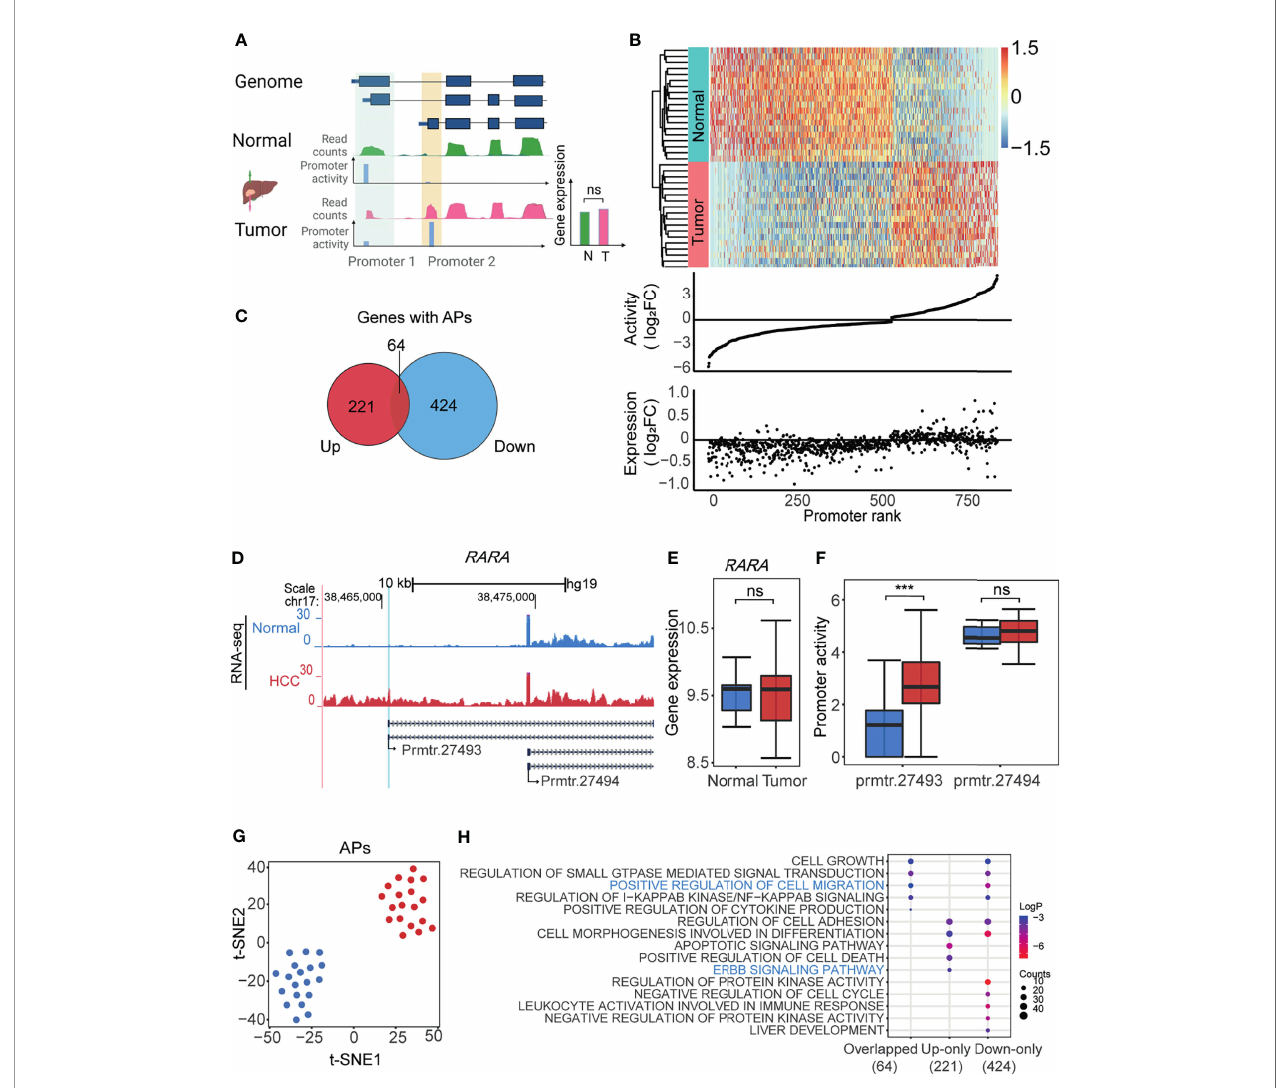
FIGURE 2 | Identi fi cation of alternative promoters (APs) in HCC. (A) The schematic illustration of the approach to identify APs in HCC. The promoters with differential activities (tumor vs. normal) but without differential expression were de fi ned as APs (see also Materials and Methods ). Green track and red track represent gene expression of normal and tumor tissue normalized by reads counts; blue tracks represent the activity of each promoter. (B) Heatmap showing the normalized promoter activities of APs for HCC and paired normal tissue (upper). The middle and bottom dot plots represent AP activity and gene expression normalized by log 2 FC. Promoters ranked by log 2 FC normalized promoter activity. (C) Venn diagram showing 64 genes with APs concurrently harboring both upregulated (Up) and downregulated (Down) promoters. (D) UCSC genome browser screenshot showing mean read count of prmtr.27493 and prmtr.27494 at the RARA gene locus in HCC (red track) and normal tissues (blue track). (E) The boxplot showing the expression of gene RARA in tumor and normal was nearly the same. ns: not signi fi cant. p-value > 0.05 (ANOVA, p-value = 0.88). (F) The boxplot showing promoter activity of prmtr.27493 was signi fi cantly higher in HCC samples. *** p -value <0.001 (ANOVA, p -value = 1.35e-04). (G) t-SNE plot showing normal (blue dots) and HCC (red dots) samples can be clustered by activities of all APs. (H) Bubble plots showing the enriched biological processes by gene ontology (GO) analysis of gene groups in (C) . Bubble color represents the log 2 ( p -value) while the bubble size represents enriched gene